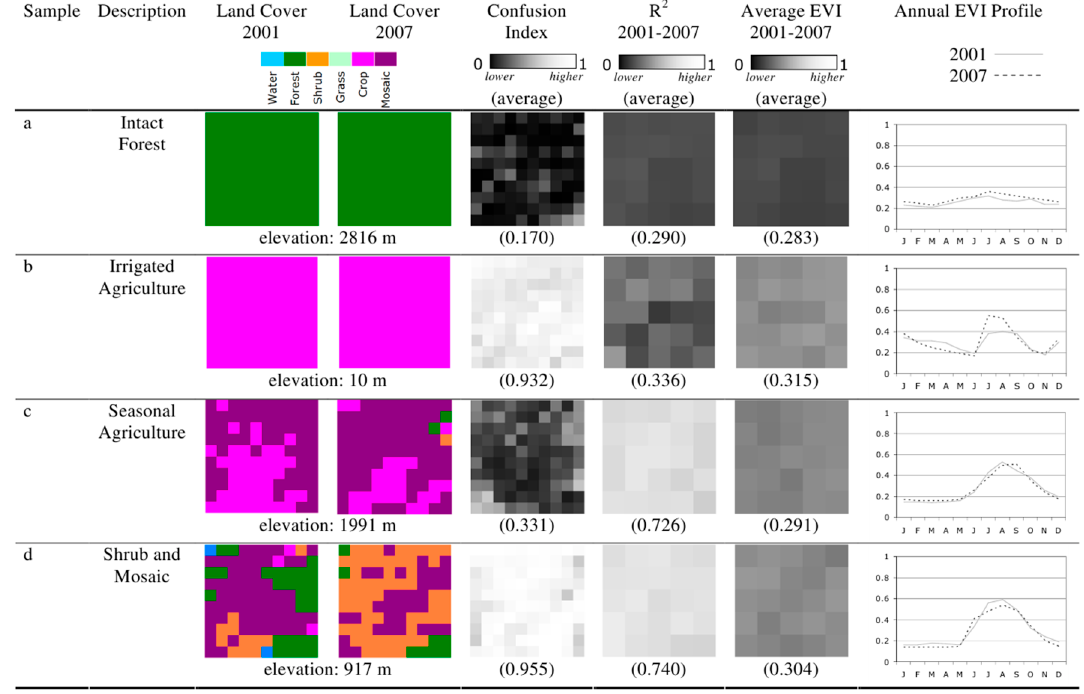
Figure 5. Selected samples of land change scenarios, including land cover 2001 and 2007, Confusion Index, Model Performance, Average EVI, and Annual profiles. ( a ) Intact forest; ( b ) Irrigated agriculture; ( c ) Seasonal agriculture; ( d ) Shrub and Mosaic.